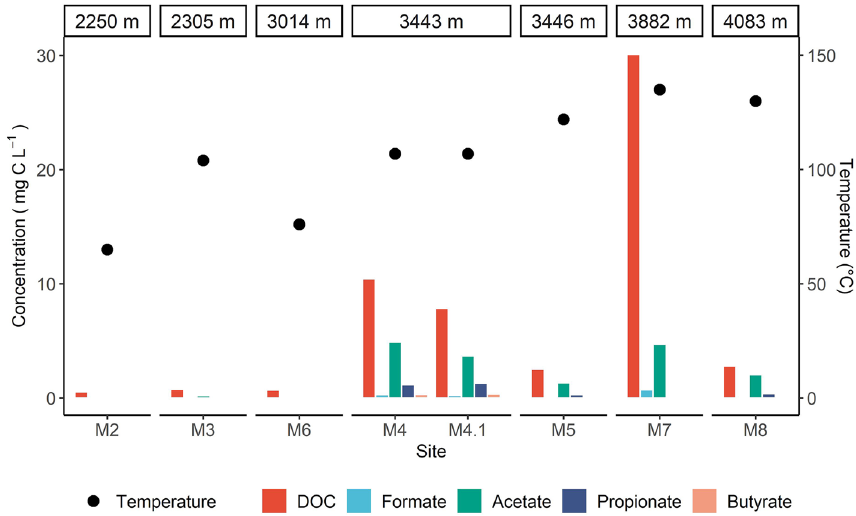
Fig. 8 Average DOC, formate, acetate, propionate, butyrate concentrations ( mgCL − 1 ) and the temperature for each reported site of the Molasse Basin. The sites on the x‑axis are arranged by the well depth (shallowest to deepest from left to right. Missing data represent either data below detection limit or not reported